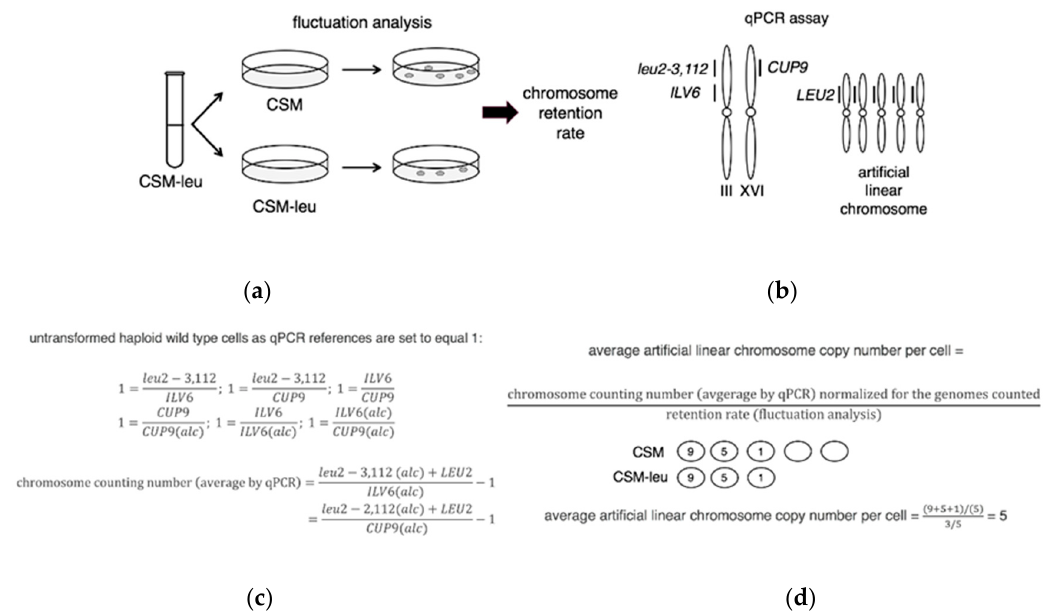
Figure 1. Measurements in a population of yeast of the average artificial chromosome copy numbers per cell: ( a ) Genetic fluctuation assays were performed by initially growing clones in selective CSM-leu media overnight and then plating them on CSM and CSM-leu to measure the average retention rates (3 / 5 = 60% in this example); ( b ) A schematic diagram of the qPCR assay to measure the number of copies of the leu2-3,112 + LEU2 loci present in the isolated genomic DNA from a population of cells. The IVL6 locus on chromosome III and CUP9 locus on chromosome XVI served as internal controls that remain at an equal 1:1 ratio with each other and with the endogenous leu2-3,112 locus, where the small vertical lines represent the qPCR products. PCR primer pairs were designed to ensure amplification of both leu2-2,112 and LEU2 at the same level. In this example, the qPCR cycle-threshold (Ct) for the leu2-3,112 + LEU2 locus primer pair would occur earlier relative to an untransformed wild type cell population containing only the single leu2-3,112 locus on chromosome III (the schematic is meant to represent a population of cellular genomic DNA containing an average of 5 artificial linear chromosomes – in a real population made up of many individual cells, some cells would carry more artificial chromosomes and others would carry fewer artificial chromosomes); ( c ) in all qPCR reactions untransformed wild type haploid or diploid cells were employed as reference controls where the ratio between the leu2-3,112 and ILV6 and CUP9 internal controls could be set to equal 1, and then were employed to normalize the measured ILV6 and CUP9 signals from qPCR reactions in samples containing artificial linear chromosomes (alc). The average chromosome counting number is defined as the qPCR signal measured relative to the ILV6 and CUP9 internal controls, minus 1 in haploids to remove the over-count of the endogenous leu2-3,112 locus; ( d ) Calculating the average artificial linear chromosome copy numbers per cell. The qPCR amplifies genomic DNA isolated from a population of cells which will include cells that have very recently lost the artificial linear chromosome (for example, in the last mitotic division), even when under selection, but that have not yet died (in this example, 2 cells have lost the artificial chromosomes and 3 cells have retained them; where a total of 20 leu2-3,112 + LEU2 loci would be amplified during qPCR off of the genomic DNA of these 5 cells; the over-count of the leu2-3,112 signal would be subtracted out as described above in ( c ) leaving a total of 15 LEU2 loci distributed among genomic DNA from 5 cells giving rise to an underestimate of an average of 3 copies of LEU2 per cell). The retention rate reveals the true number of cells in the population that have retained the artificial chromosome at the moment of isolation of the genomic DNA (3 cells in this example with 9, 5, or 1 copy(ies) of the artificial linear chromosome). The true average copy number of artificial linear chromosomes in the population of cells that have retained the chromosomes is determined by normalizing the measured qPCR average copy number by the number of genomes counted as quantified by the amount of the genomic DNA added as a template to the qPCR reaction sample (5 in this example) divided by the retention rate (3/5 in this example) to yield the final result: an average of 5 copies of the artificial linear chromosomes per cell.